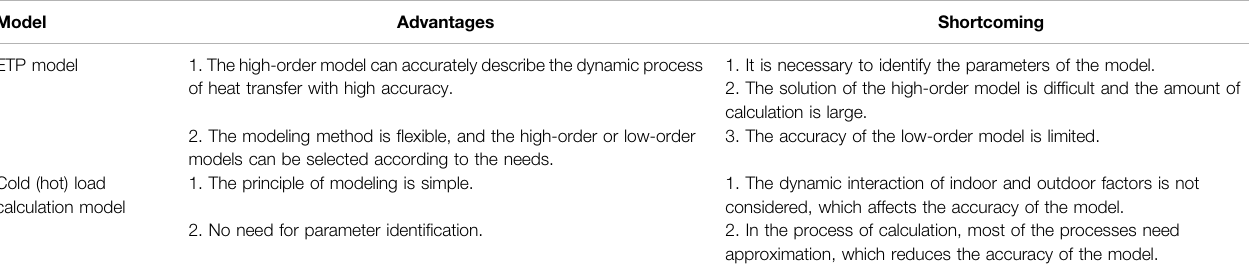
TABLE 1 | Features of two thermodynamic models.